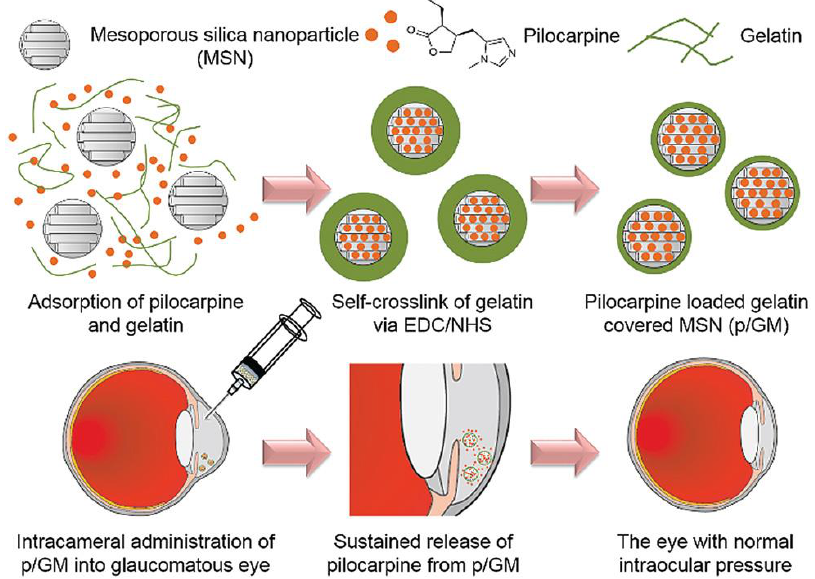
Figure 3. Schematic illustration showing synthesis of silica nanoparticles covered by pilocarpine-loaded gelatin (p/GM) as an ocular drug delivery system (DDS) to decrease the intraocular pressure (IOP) through intracameral injection into the anterior chamber of rabbits’ eye. Reproduced with permission from Reference [94].